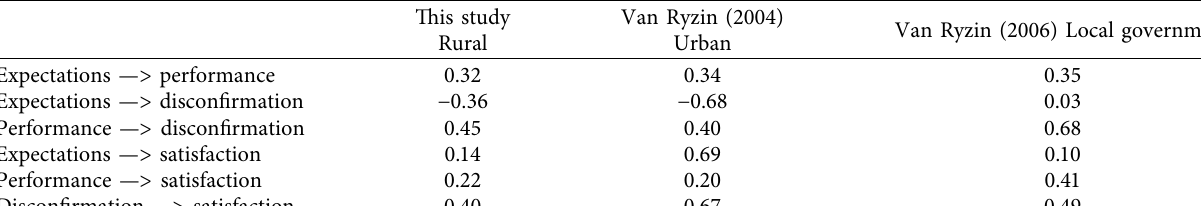
Table 3: Comparisons of path coefficients with earlier